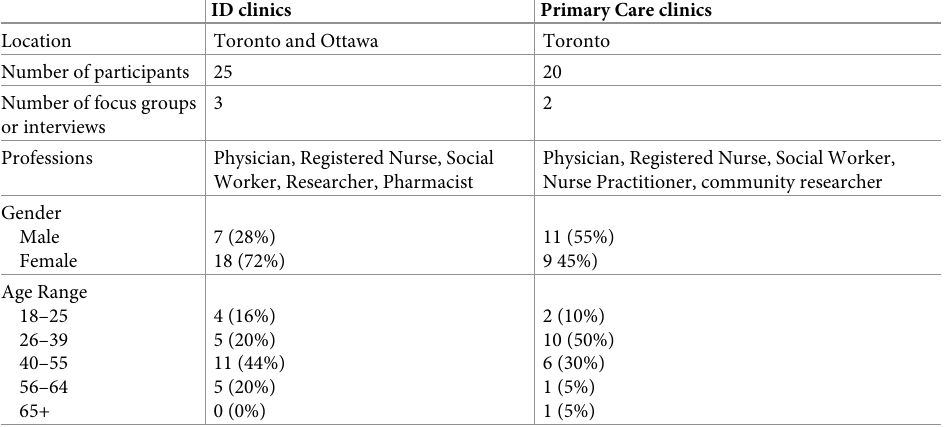
Table 1. Health care providers demographic